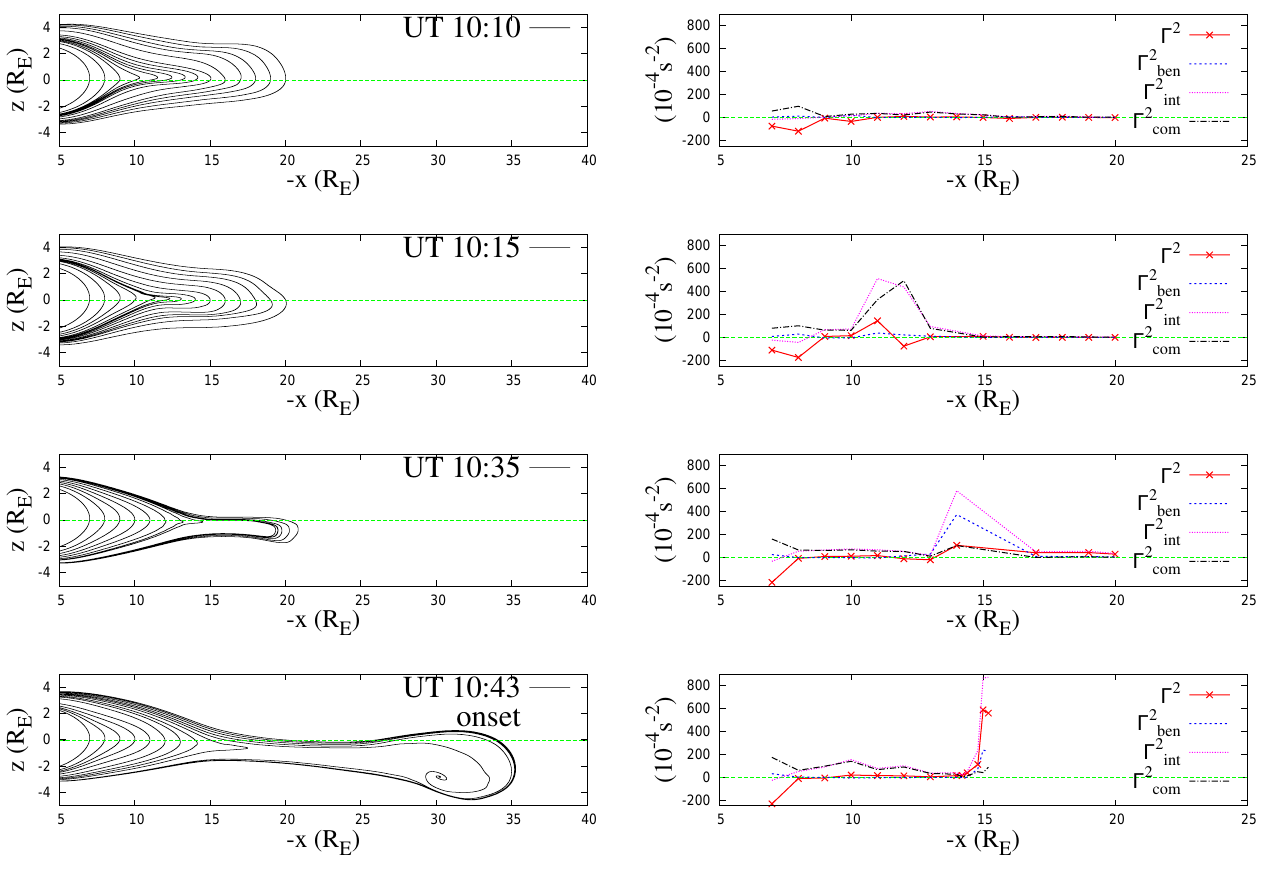
Fig. 5. Left column: Magnetic field lines within the meridian plane ( y = 0) crossing the region 7 . − x . 20 in the equatorial plane ( z = 0) at the four selected time slices prior to the first aurora intensification; Right column: Square of growth rate 0 2 (red sold line with the symbol “ × ”), the line-bending contribution 0 2 (blue short dashed line), the interchange contribution 0 2 (magenta dotted line), and the compression ben int contribution 0 2 com (black dot dashed line), for the ballooning modes along the magnetic field lines shown in the left column. Each field line is identified by the x-coordinate of its crossing location in the equatorial plane ( z = 0). In both columns, the green dashed lines represent the zero horizontal